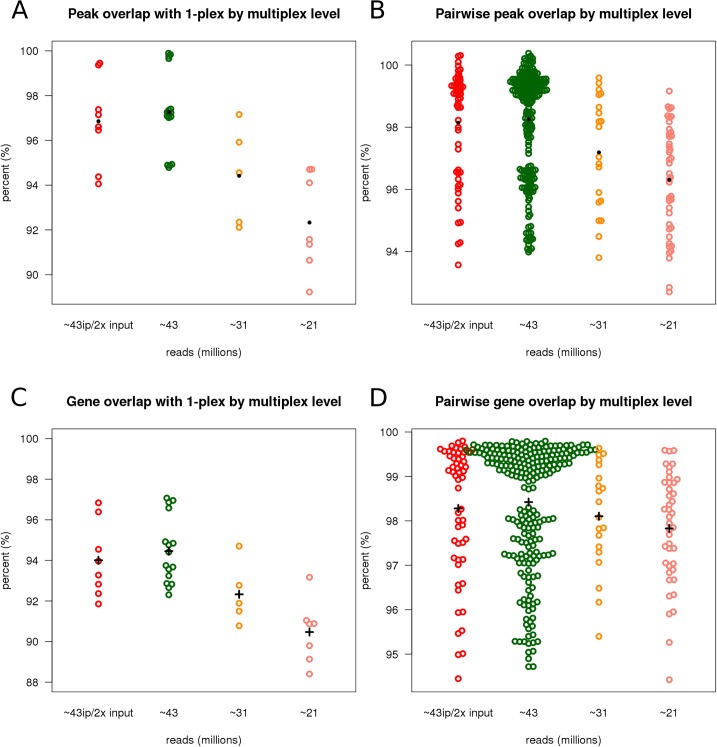
Overlap of detected peaks and gene annotation overlap across multiplex levels.A) The percent overlap of peaks for each sample to 1-plex across multiplex levels. As multiplexing increases there is a shift towards decreasing overlap. However, the overlap of peaks called from multiplexed samples with peaks identified in the non-multiplexed sample is generally above 92%. B) The percent overlap of each sample pairwise across multiplexed libraries. Overlap among peaks called from samples with similar coverage is generally above 94%. There is a similar trend, as in A, that as multiplexing increases overlaps start to decrease. C) The overlap of gene annotations of peaks called from each multiplexed sample compared to peaks from the non-multiplexed sample. Generally, as multiplexing increases more than 90% of the genes annotated in 1-plex are present in the gene annotations of multiplexed libraries. D) The percent of overlap of gene annotations pairwise for each sample.